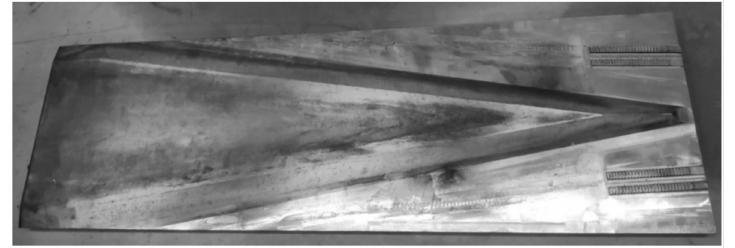
Figure 3. Tool (wedge with a variable forming angle α ) used in the CWR